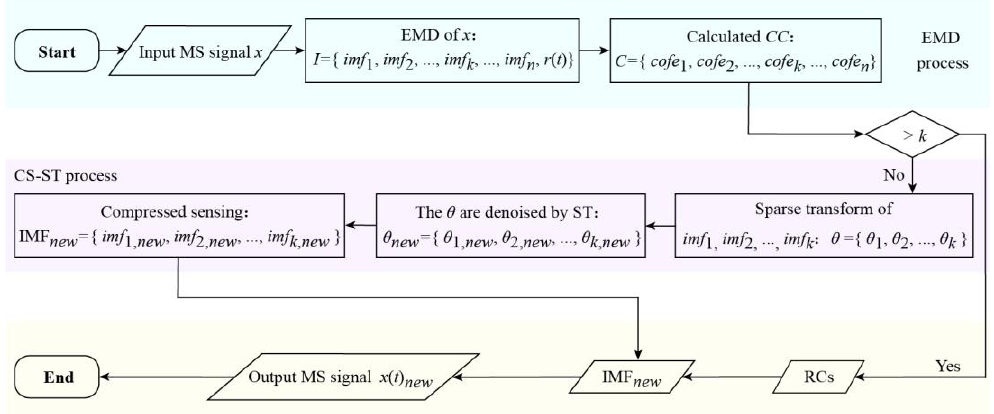
Figure 4. The EMD_CS_ST algorithm flow chart. First, Empirical Mode Decomposition (EMD) is performed on the MS signal. Then, CS_ST is used to denoise the Intrinsic Mode Functions (IMF) components to be denoised. Finally, the denoised components and the remaining IMF components are combined to obtain the final effective signal.